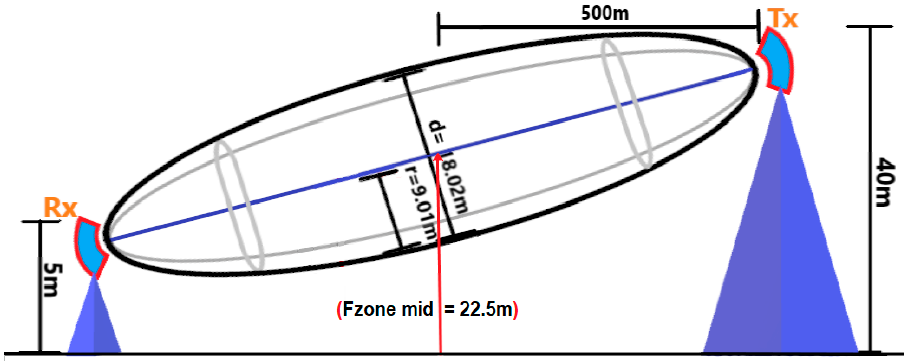
Figure 13. The calculation of the Fresnel zone between the transmitter and the receiver at the first distance (1 km).